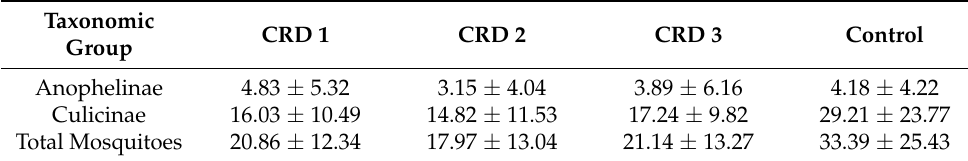
Table 2. Hourly human landing collections (Means ± SD) recorded for devices with insecticide (CRD 1, CRD 2, CRD 3) and with no metofluthrin (Control) by mosquito taxonomic